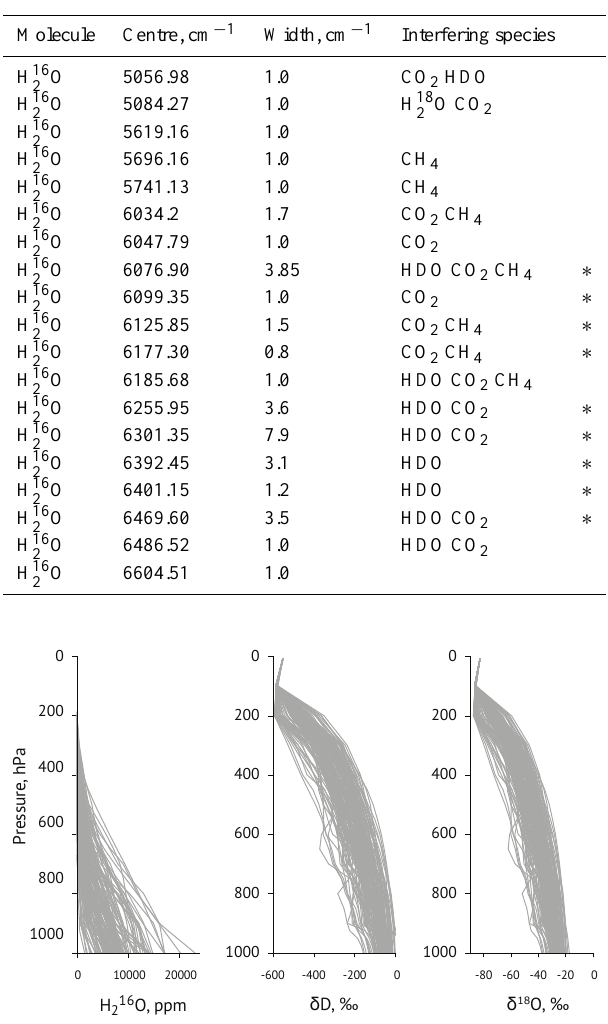
Figure 3. The ensemble of the H 2 O, δ 18 O and δ D initial guess pro- files derived from NCEP/NCAR reanalysis